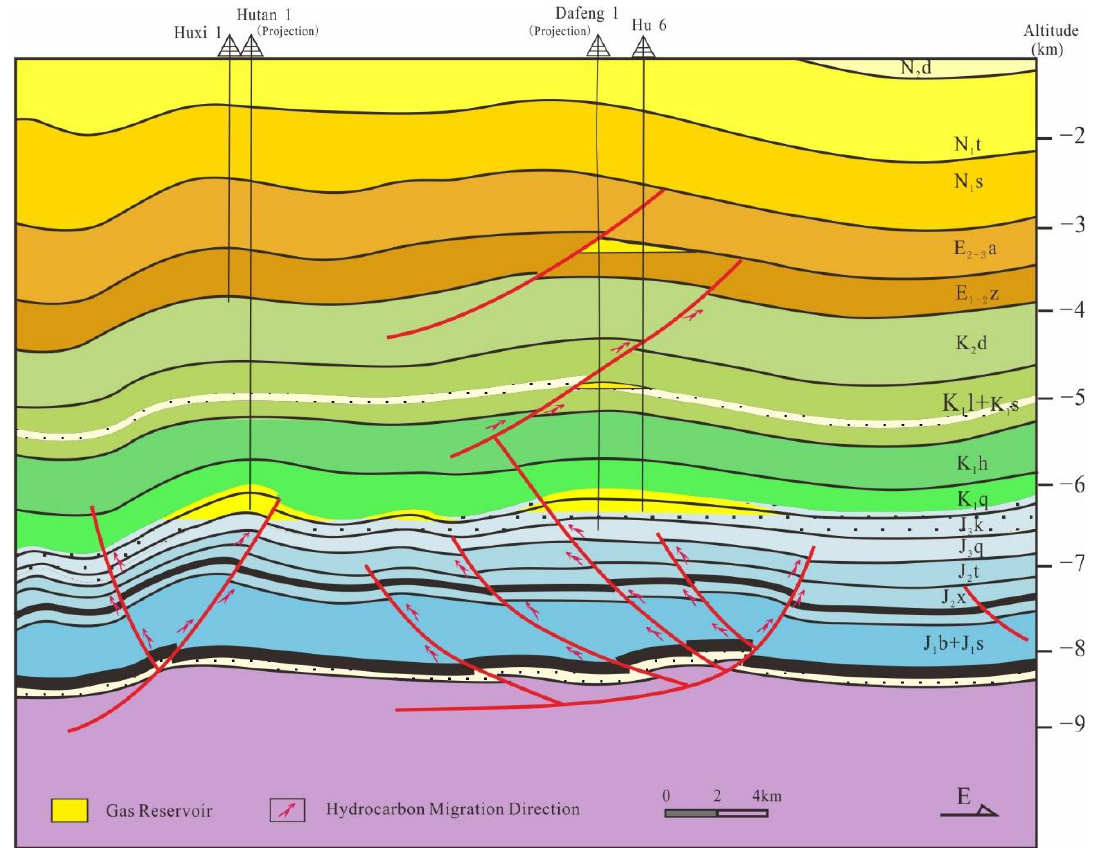
Figure 8. Hydrocarbon accumulation model of Hutubi anticline.